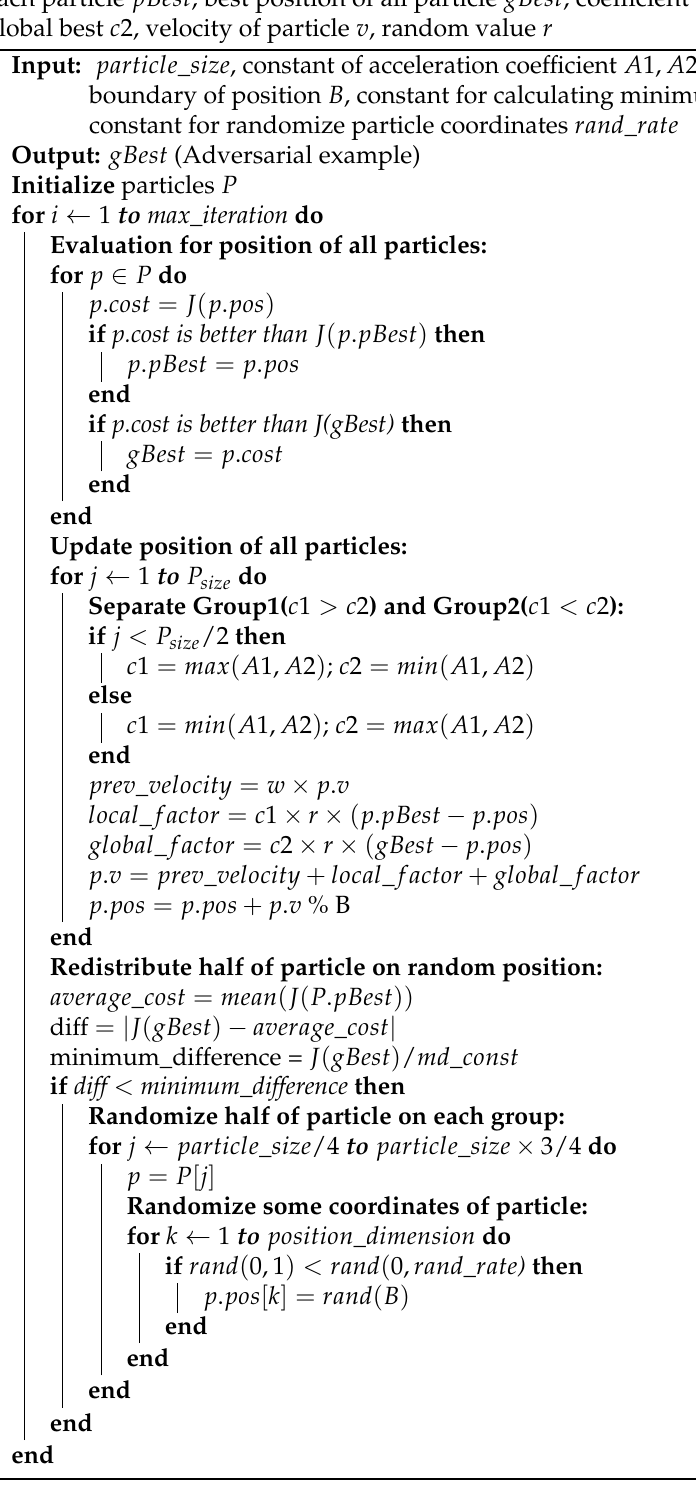
Algorithm 1: MGRR-PSO Attack - for cost function J , position of particle pos , best position of each particle pBest , best position of all particle gBest , coefficient of local best c 1, coefficient of global best c 2, velocity of particle v , random value